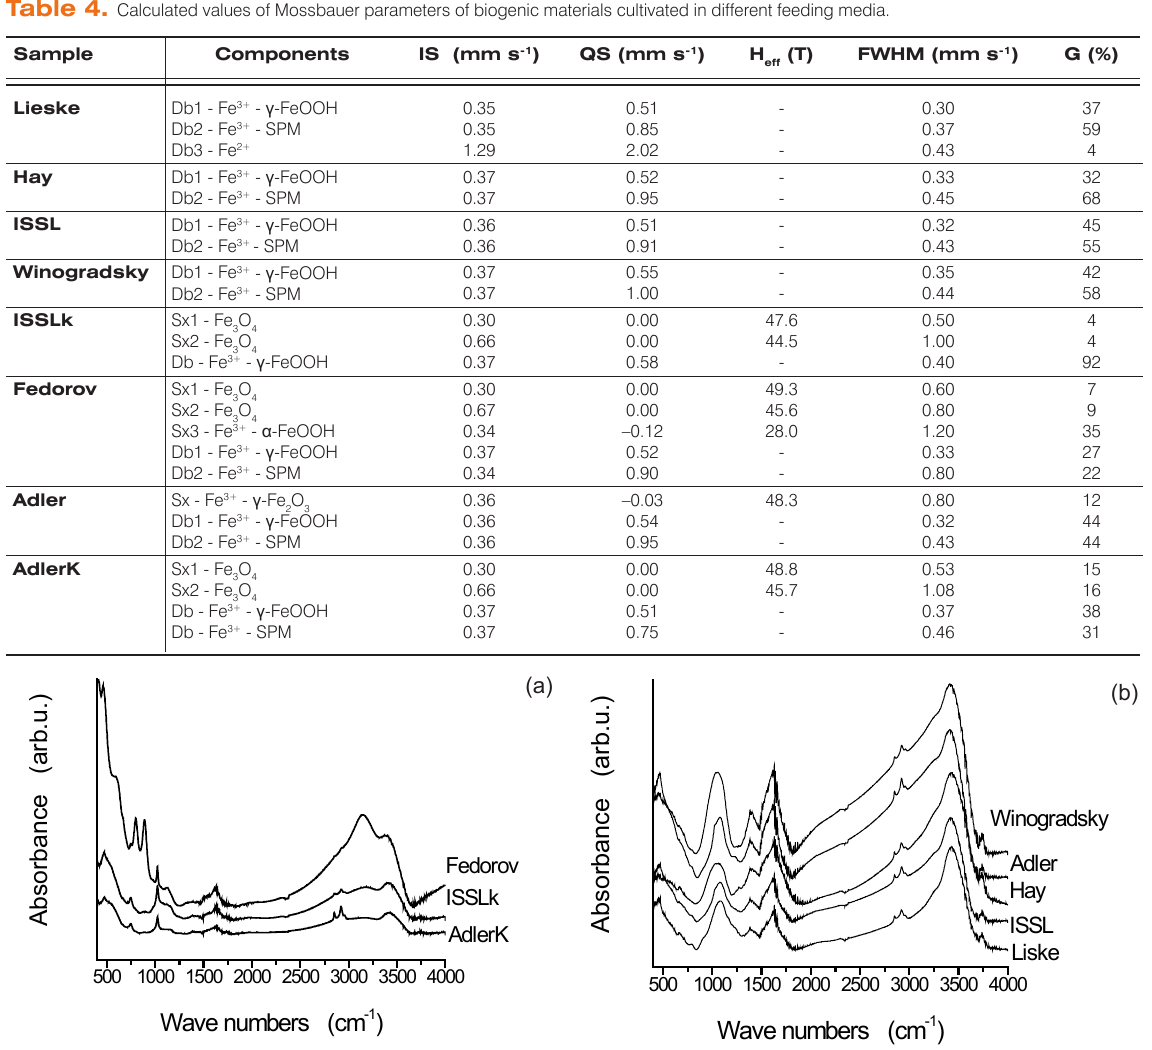
Figure 9. IR spectra from KBr pellet of samples obtained after iron bacteria cultivation and activity/life in different feeding